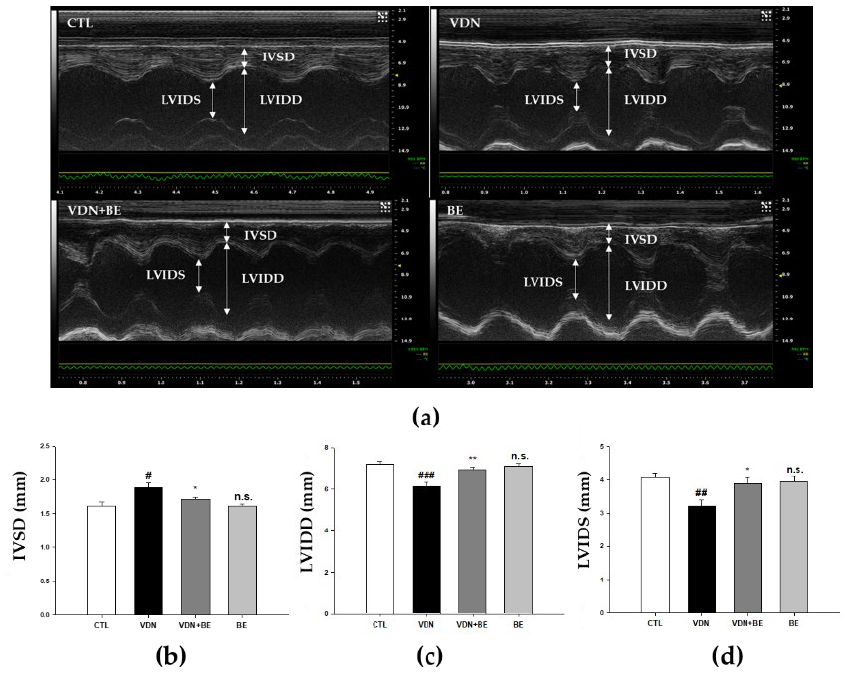
Figure 7. The effects of baicalein on cardiac performance in SD rats. The M-mode images were represented from individual groups by echocardiograph observation. ( a ) Echocardiogram, ( b ) IVSD, ( c ) LVIDd, and ( d ) LVIDs. Each point represents mean ± SEM, n = 10. # p < 0.01; ## p < 0.01; ### p < 0.001 vs. control group; * p < 0.05; ** p < 0.01 vs. VDN group; n.s. mean not significant vs. control group.